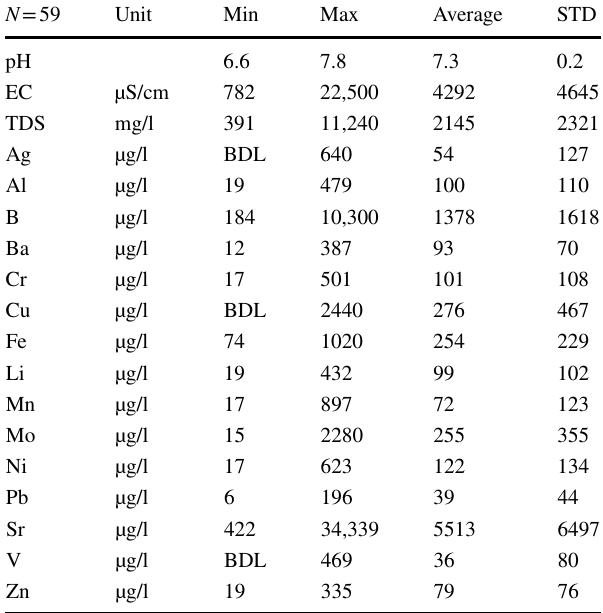
Table 2 Descriptive statistics for pH, EC, TDS and metals